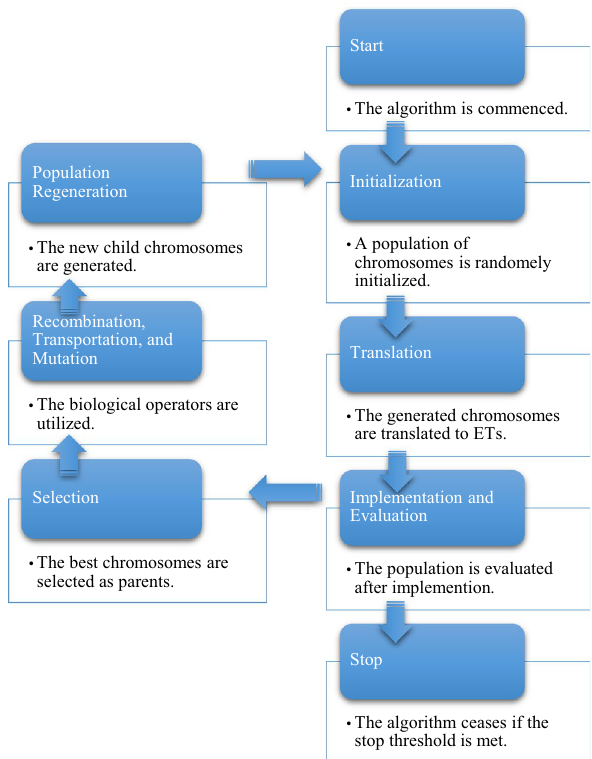
Fig. 2 The flowchart of the GEP algorithm